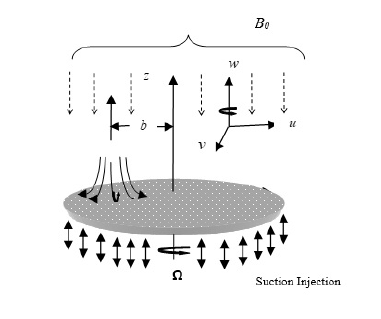
Fig. 1: Flow structure of physical